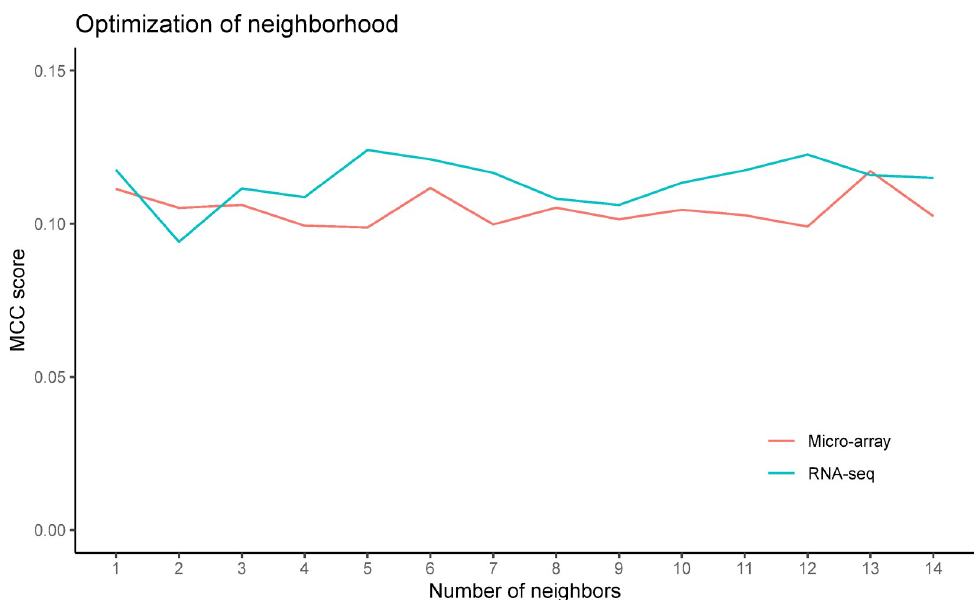
Fig 5. DELocal performance is not strongly dependent on the number of gene neighbours used in the analysis. Every gene is evaluated in relation to its neighbouring genes. In the absence of any “gold standard” for the number of neighbours, different numbers of nearest genes (within 1 Mb window) were used to identify the differentially expressed genes. The overall performances were measured using MCC. The performance of DELocal using RNAseq data was slightly better than with microarray